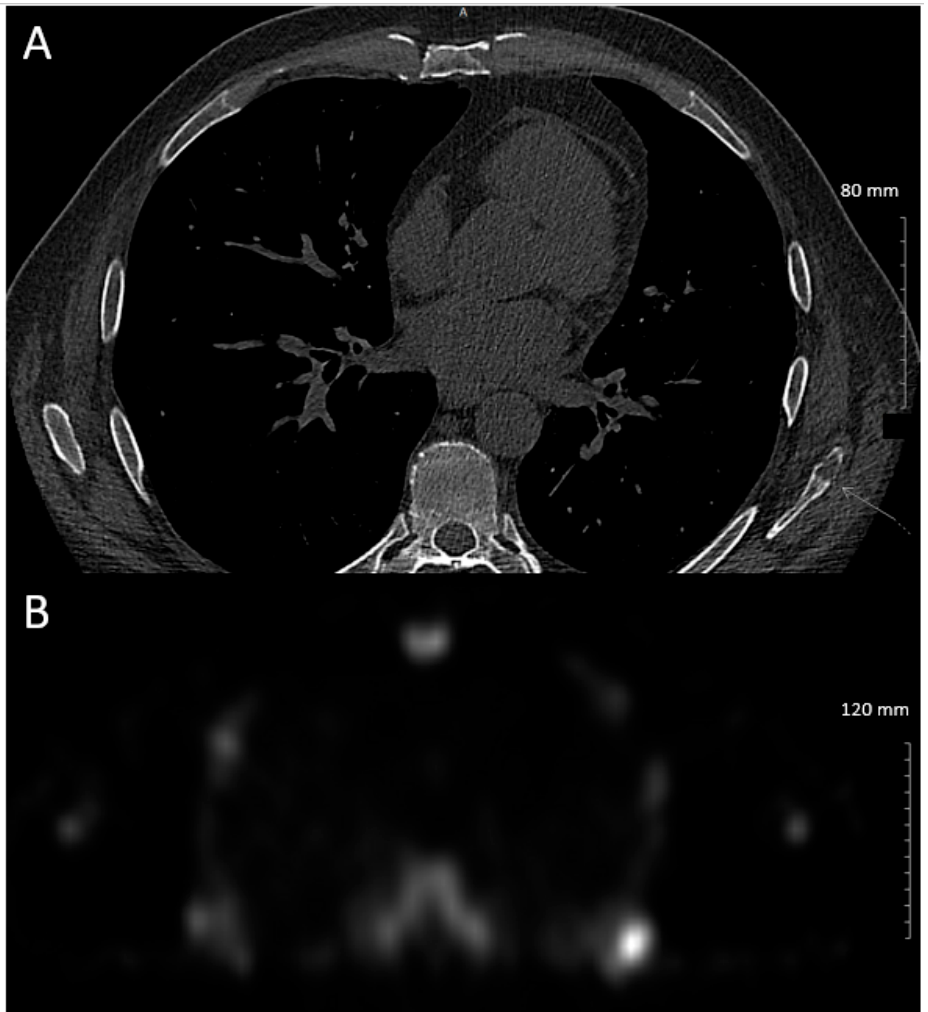
Figure 3. ( A ) Axial CT chest demonstrating osteolytic lesion at inferior tip of left scapula with suspected overlying cortical breach; ( B ) Bone scan revealing abnormal focal radiotracer uptake in the inferior tip of the left scapular body, correlating to abnormality seen on CT chest.